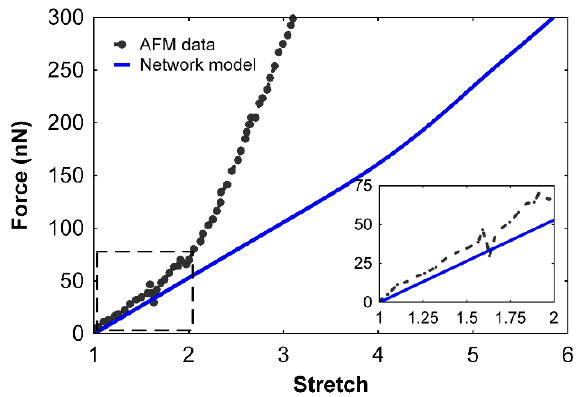
Figure 4. The force–stretch relationship comparison of a 12 μ m long, 330 nm diameter fibrin fiber from atomic force microscopy (AFM) experiments [16] (dotted line) and our network model (blue). The inset shows the zoomed in location of the curve with good agreement in the linear region.